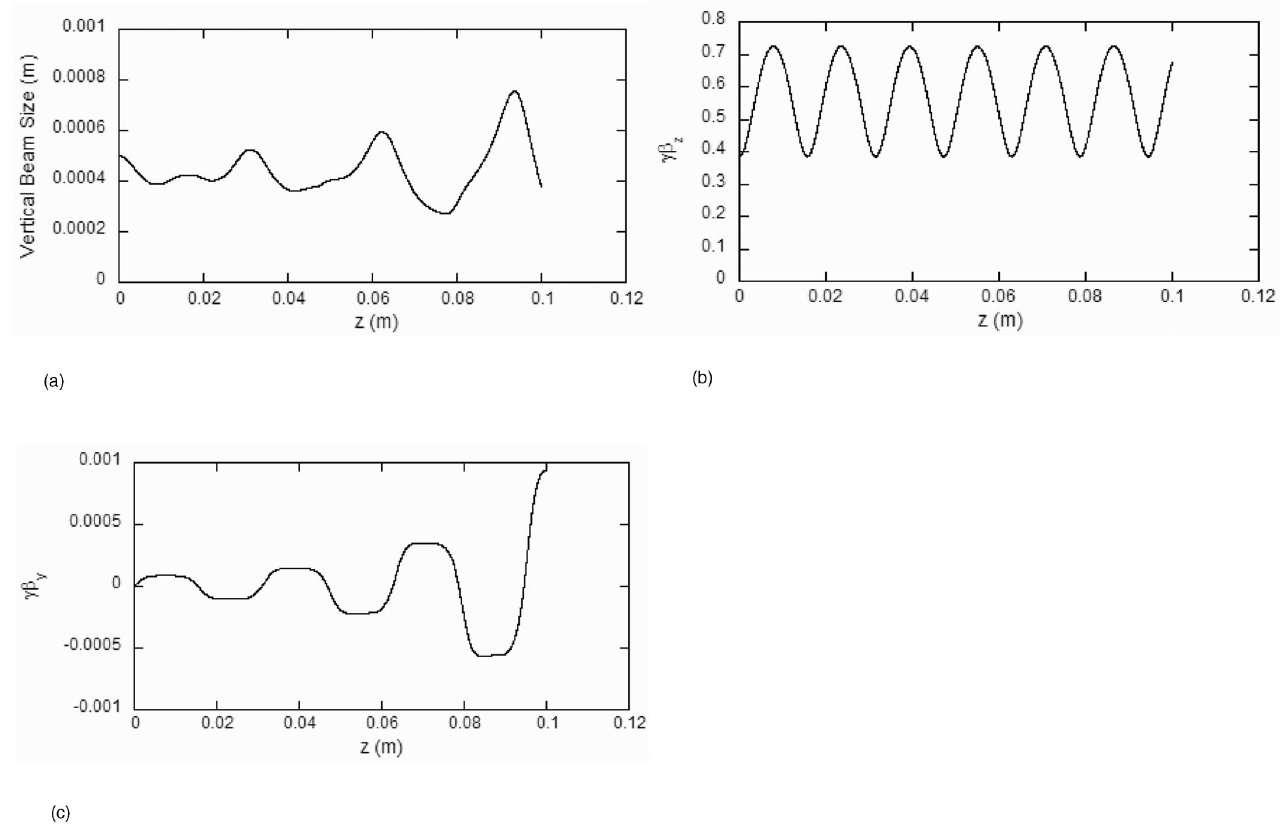
FIG. 11. Instability threshold for wiggler focusing with a space-charge dominated beam, period 3.105 cm. (a) Vertical beam size versus axial position. (b) Longitudinal beam momentum versus axial position. (c) Vertical momentum versus axial